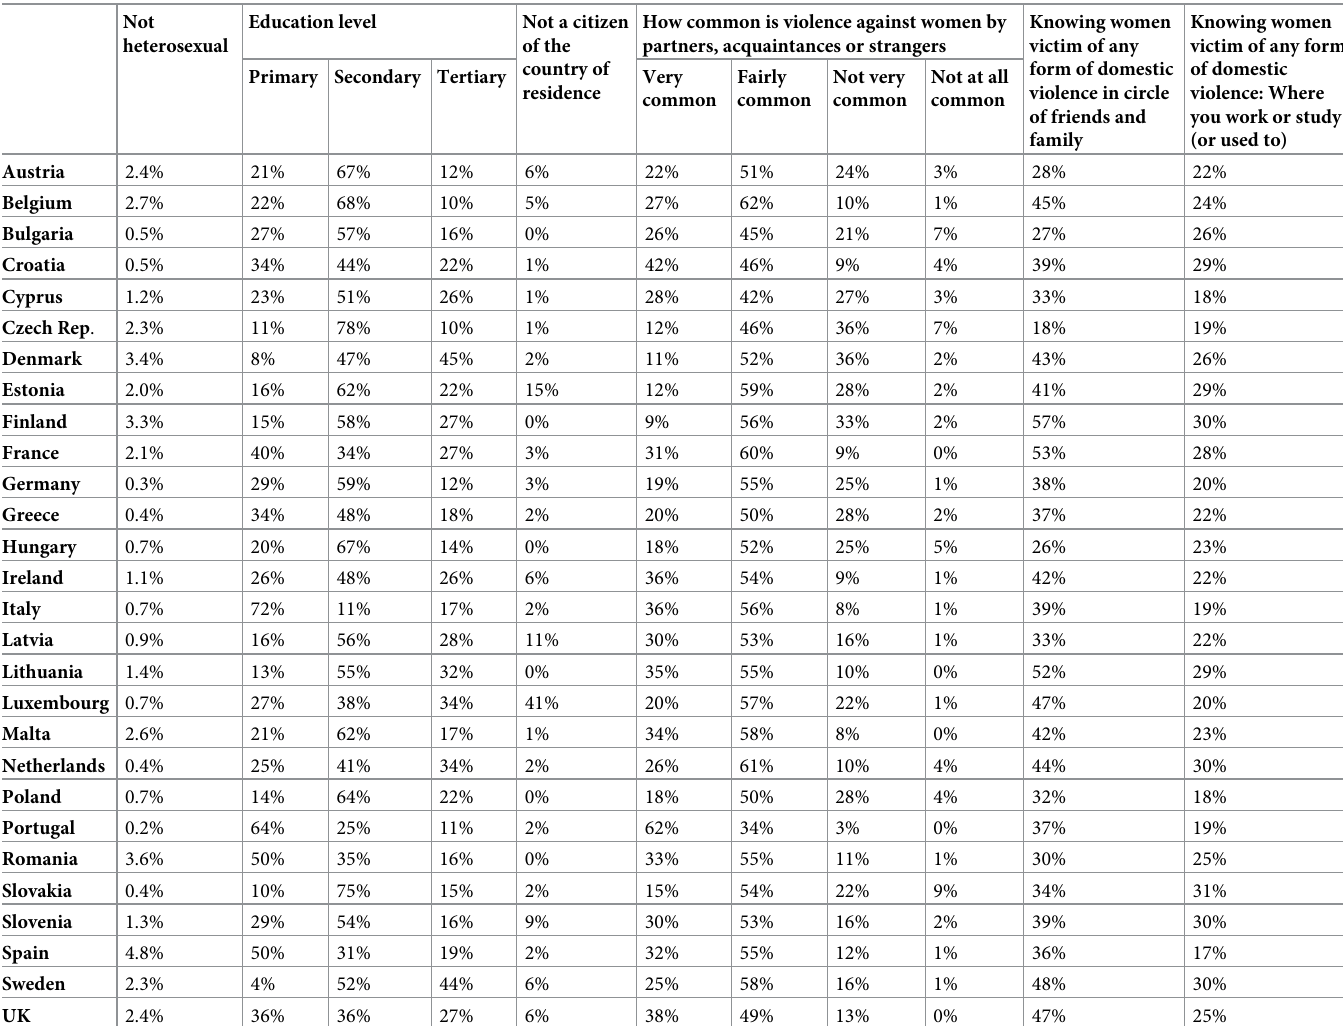
Table 5. Individual level